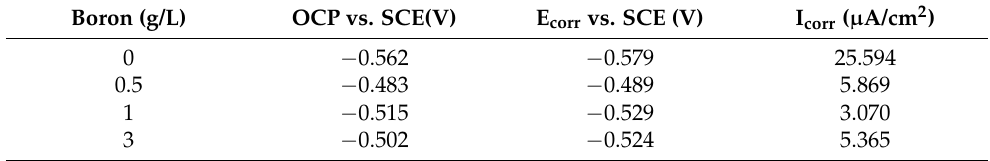
Figure 5. Polarization curves of Ni-W alloy and Ni-W/B composite coatings with varying boron concentrations (0, 0.5, 1, and 3 g/L). Table 1. OCP value, corrosion potential, and corrosion current density on Ni-W/B and Ni-W/B.